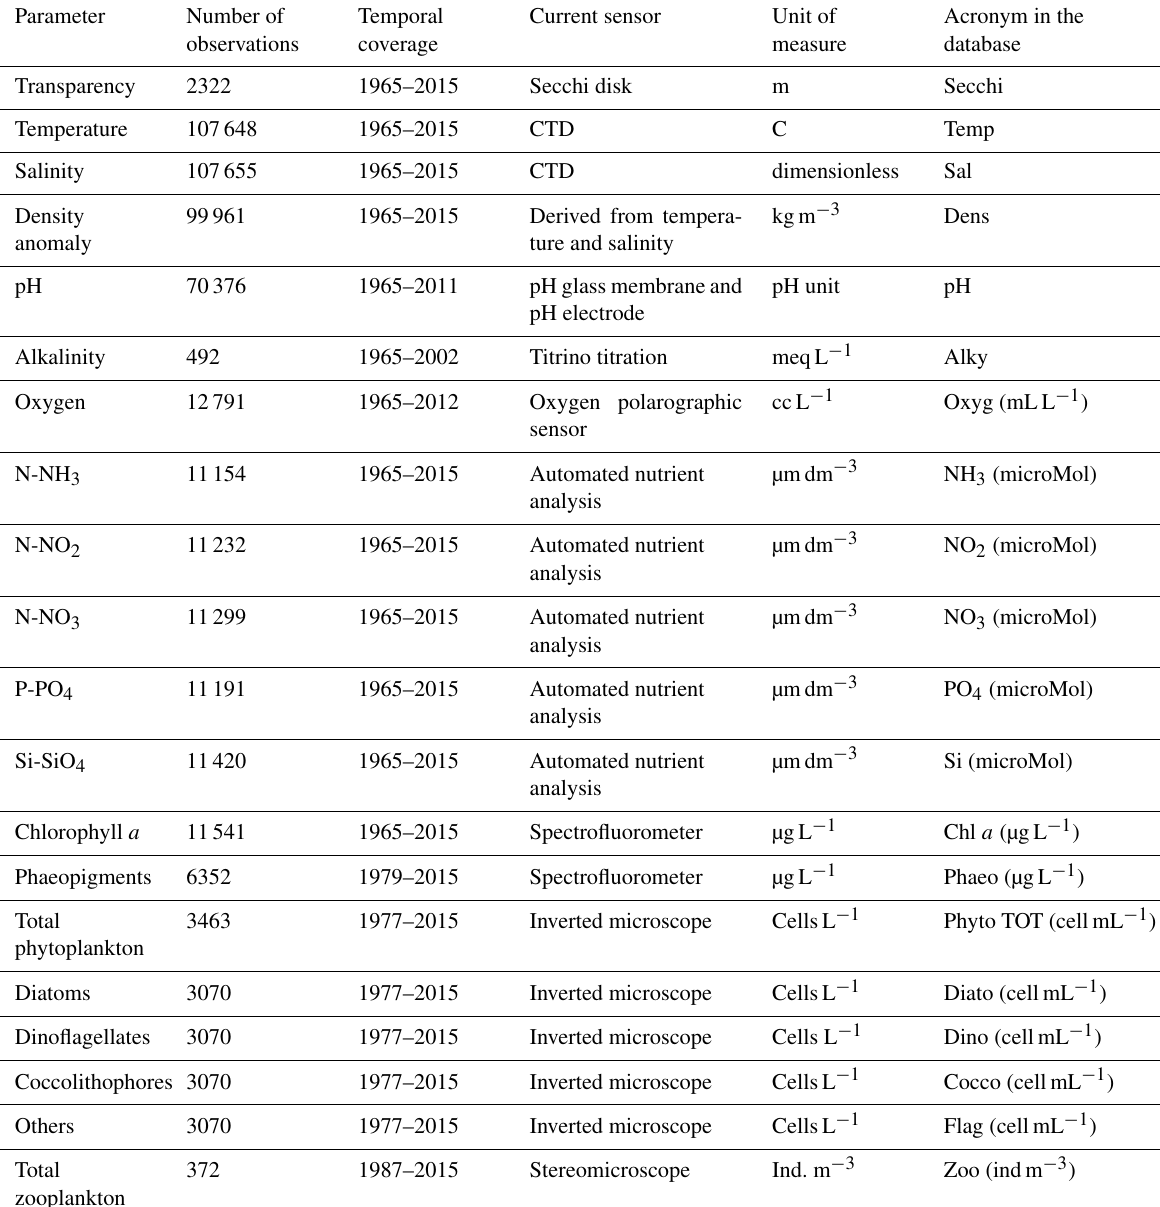
Table 2. Database parameters and main descriptive